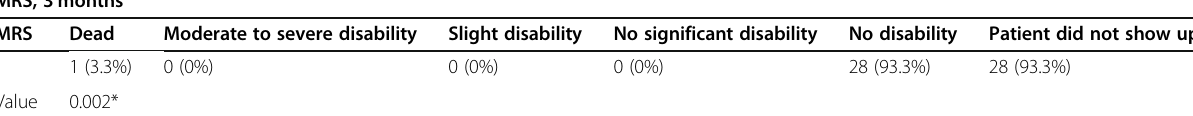
Table 6 Clinical outcome assessed at 3 months using the modified Rankin